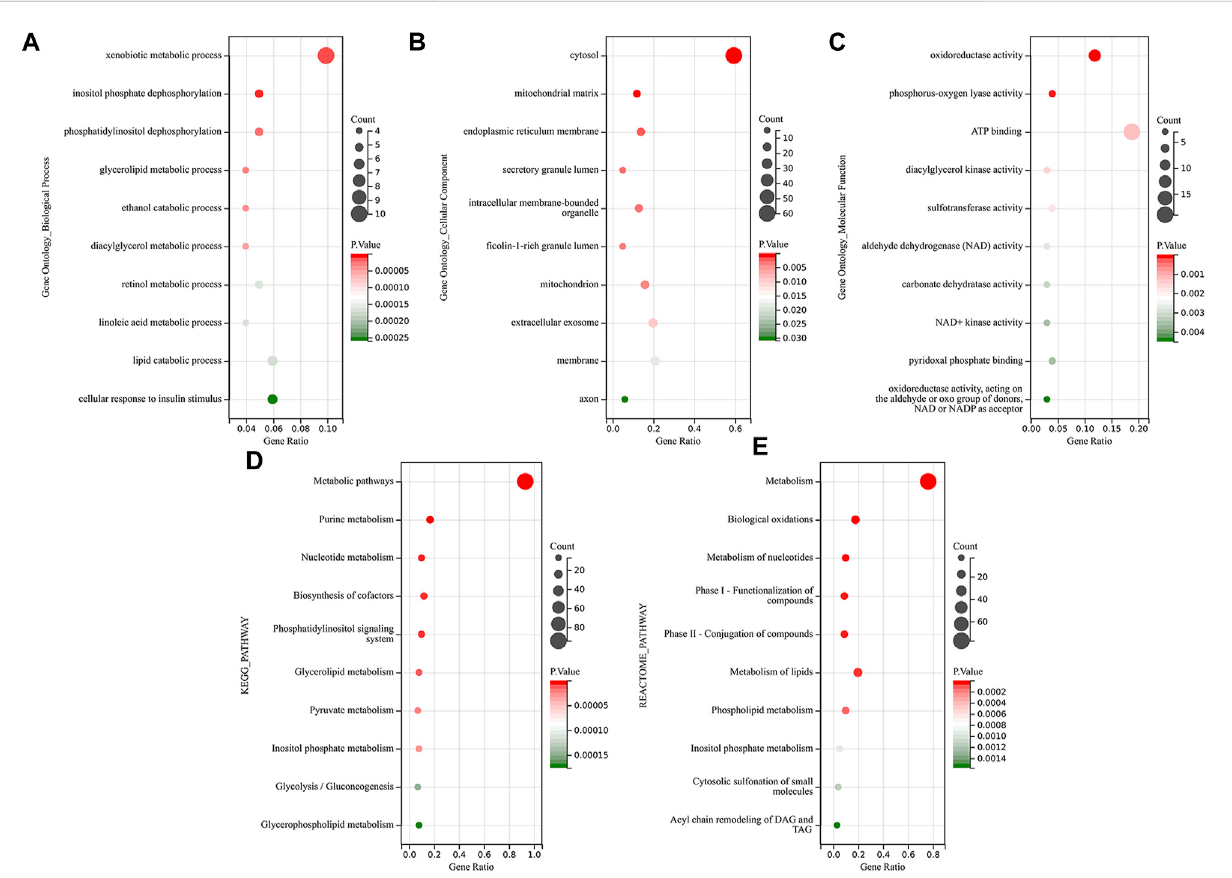
FIGURE 3 Functional enrichment analysis of DEMRGs. The dot size indicates the number of DEMRGs enriched to the corresponding term, and the dot color indicatestheenrichmentsigni fi canceofthecorrespondingterm. (A) Thetop10signi fi cantlyenrichedtermsforGeneontologybiologicalprocess. (B) The top 10 signi fi cantly enriched terms for Gene ontology cellular component (C) The top 10 signi fi cantly enriched terms for Gene ontology molecular function. (D) The top 10 signi fi cantly enriched terms for the KEGG pathway. (E) The top 10 signi fi cantly enriched terms for the Reactome